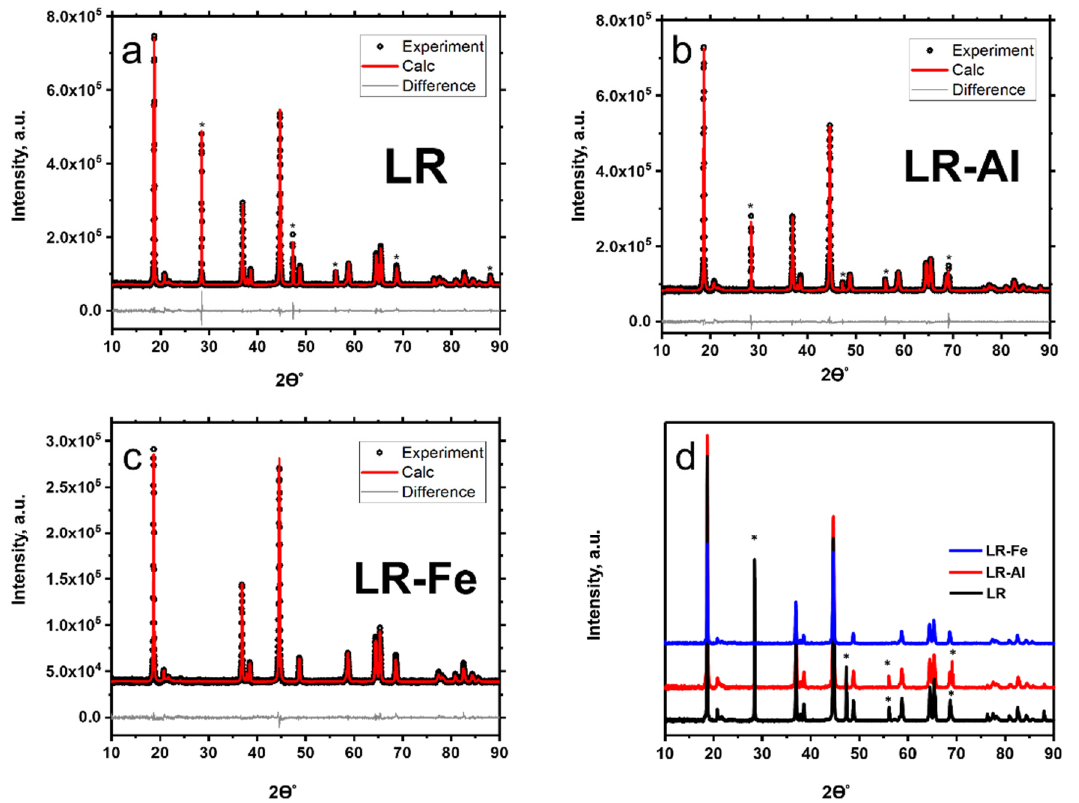
Figure 2. XRD patterns with Rietveld refinement for cathode materials: ( a ) LR; ( b ) LR-Al; and ( c ) LR-Fe. ( d ) overlay of diffractograms; the Si lines are designated by asterisks.